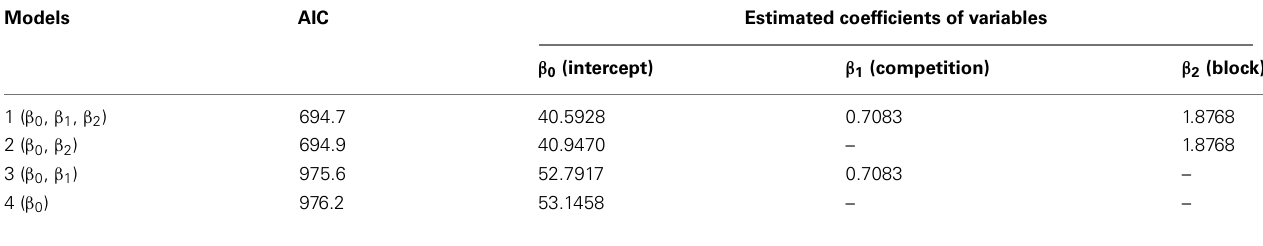
TableA5 | Daily recorded body weight (data shown in FigureA3) was analyzed by generalized linear mixed model (GLMM) with a linear function. The models 1 and 2 yielded similar AIC values, but a comparison by likelihood-ratio test revealed no significant difference between the two models ( p = 0.4492), suggesting that the competition did not influence the